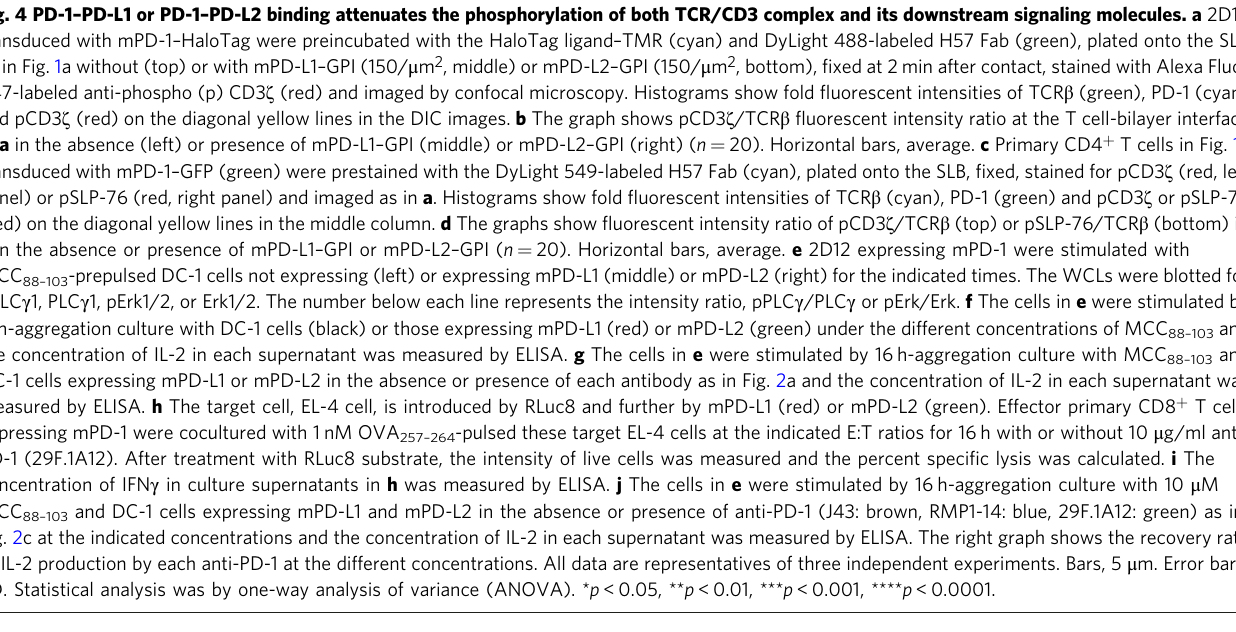
Fig. 2c at the indicated concentrations and the concentration of IL-2 in each supernatant was measured by ELISA. The right graph shows the recovery